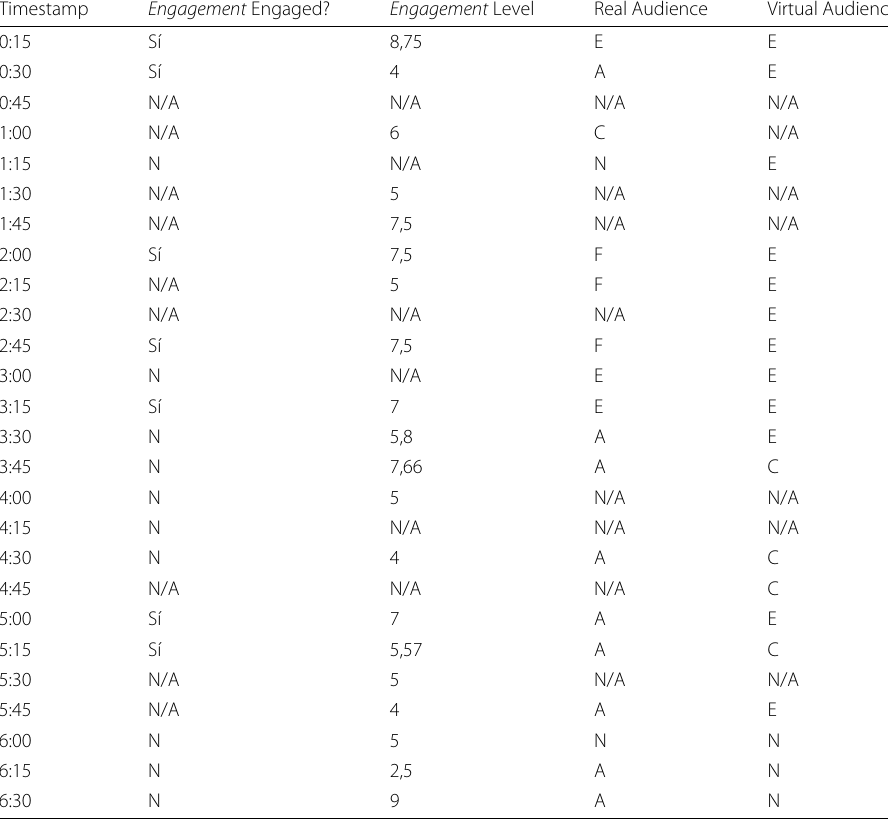
Table 5 Experiment: Results from speech #2